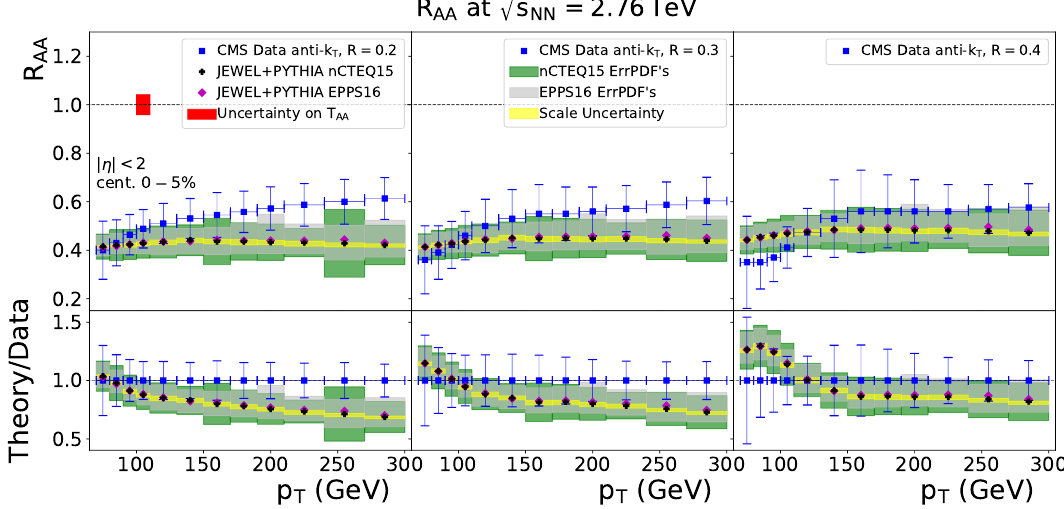
Figure 7 . Nuclear modification factor R AA for jets with radii R = 0 . 2 (left), 0.3 (centre) and 0.4 √ (right) at s NN = 2 . 76 TeV measured by CMS in the rapidity range | η | < 2 and the centrality range 0 – 5% [7] and calculated with JEWEL. Scale (nuclear PDF) uncertainties are shown as yellow (green and grey) shaded bands. The overall normalisation uncertainty on T box around